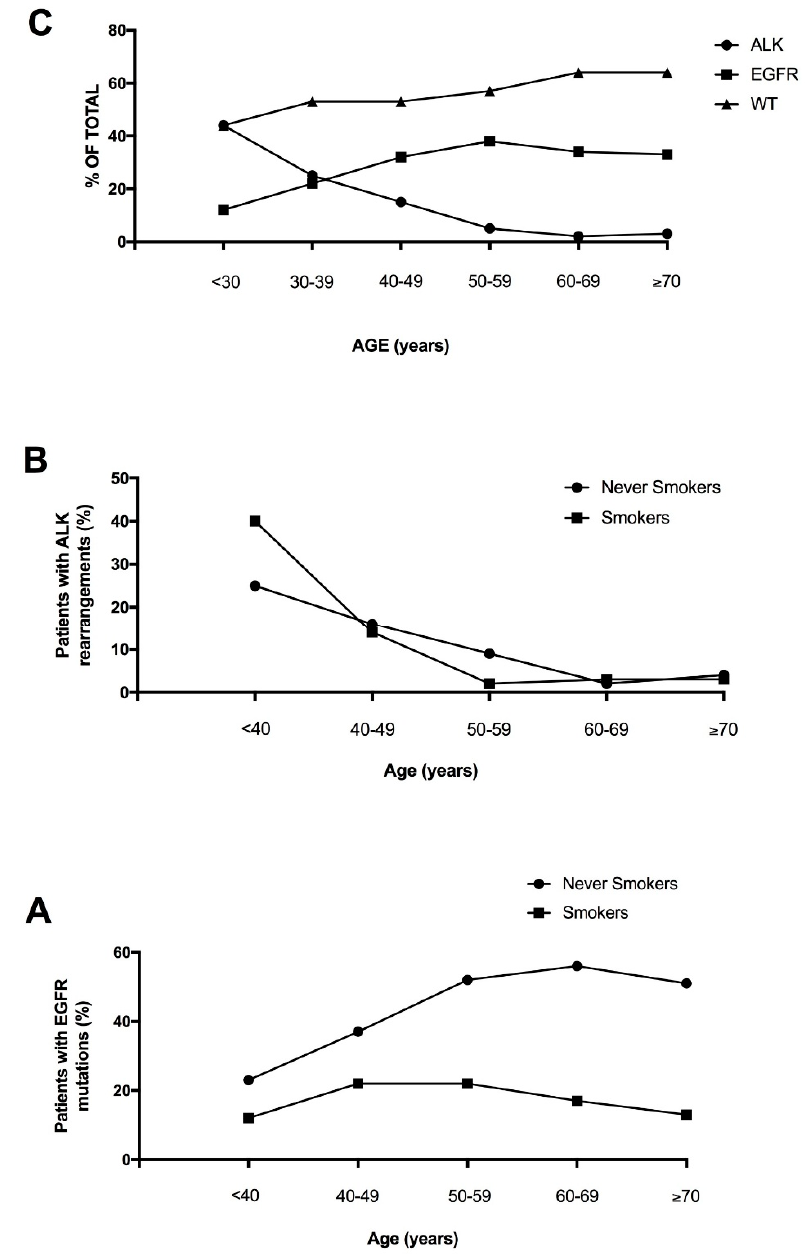
Figure 5. ( A ) Age distribution at diagnosis of Chinese NSCLC patients with ALK-EML4 rearrangements, EGFR mutations and wild type (without ALK or EGFR alterations) tumors; ( B ) age distribution of ALK-rearranged NSCLCs stratified by smoking status; ( C ) age distribution of EGFR-mutant NSCLCs stratified by smoking status.